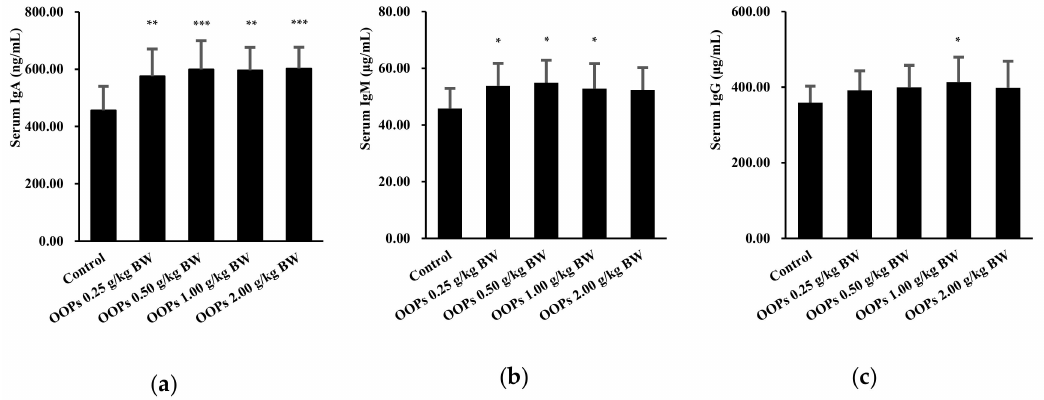
Figure 5. E ff ects of OOPs on serum immunoglobulin concentrations. ( a ) IgA concentrations in serum; ( b ) IgM concentrations in serum; ( c ) IgG concentrations in serum. Data are represented as mean ± SD, n = 10. * p < 0.05 vs. control group, ** p < 0.01 vs. control group, *** p < 0.001 vs. control